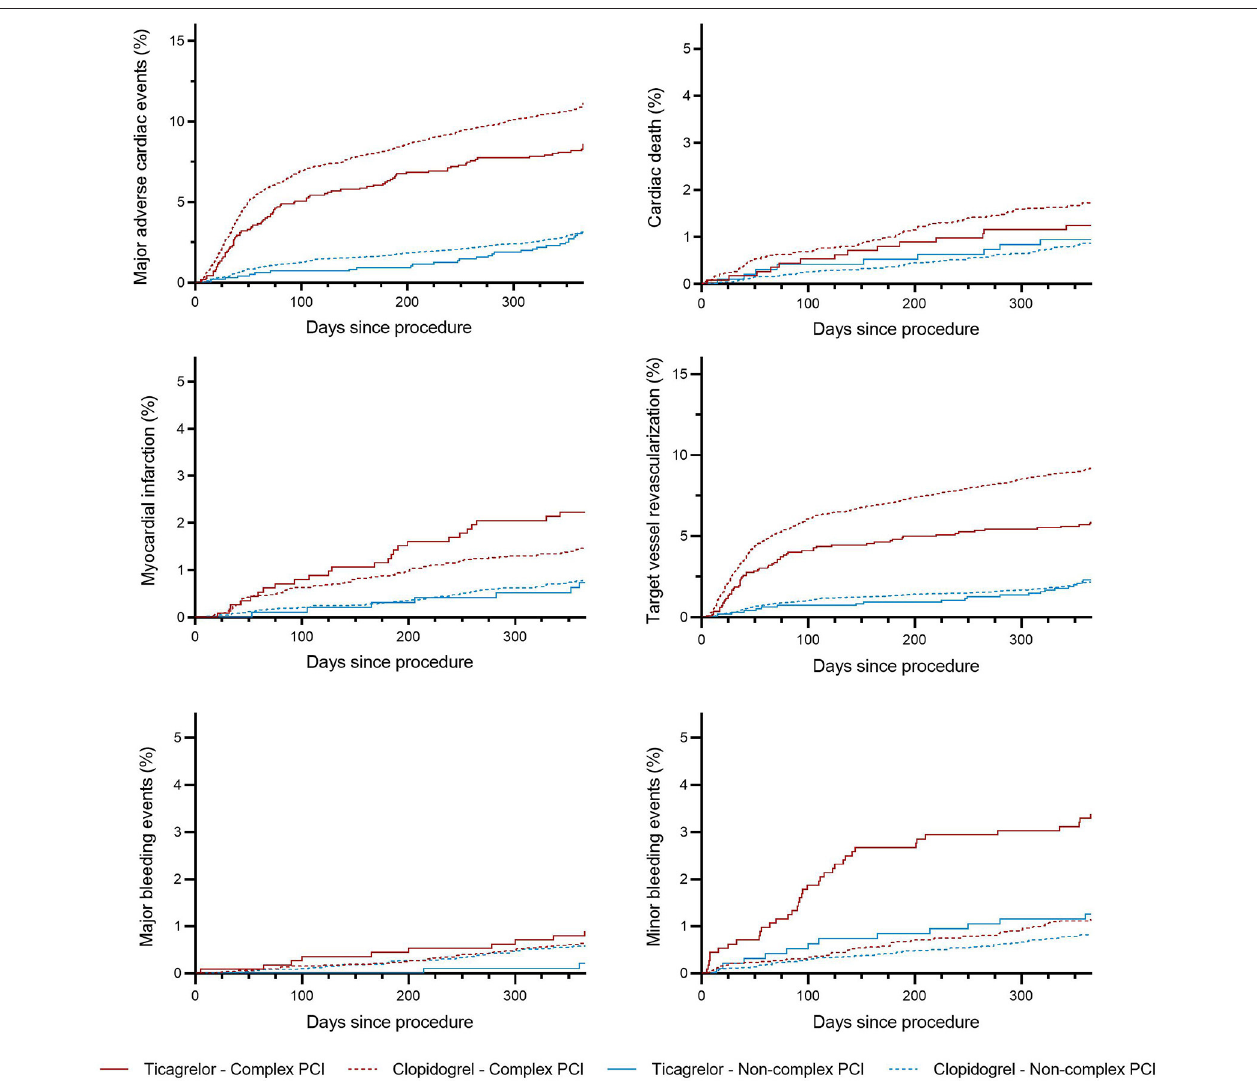
FIGURE 2 | Incidence curves for the endpoints of patients stratified by P2Y12 inhibitors and complex PCI. Kaplan–Meier curves of patients stratified according to P2Y12 inhibitors and complex percutaneous coronary intervention for endpoints, including major adverse cardiac events, cardiac death, myocardial infarction, repeat target vessel revascularization major bleeding, and minor